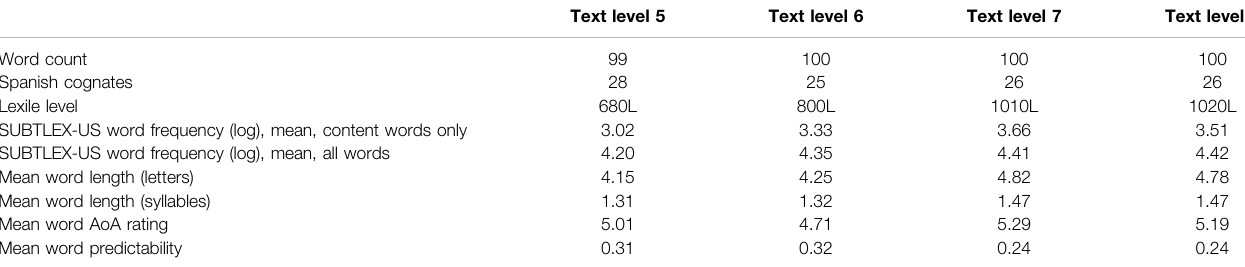
TABLE 3 | Word characteristics for passages at BRI text grade levels 5 through